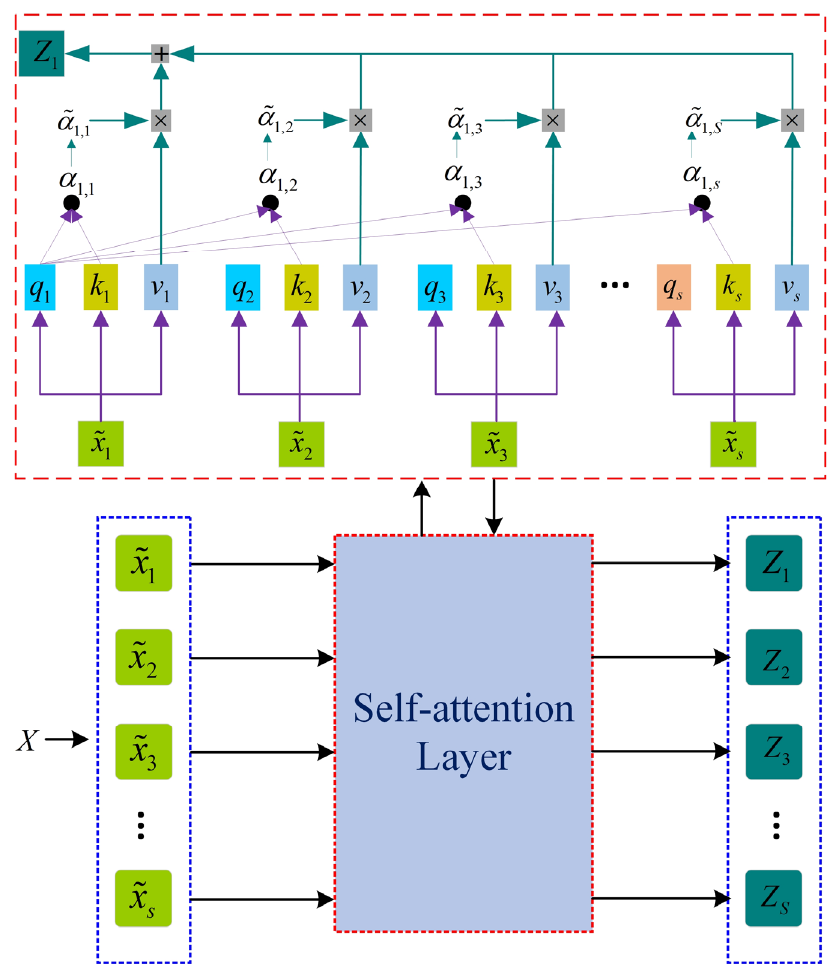
Figure 8. Frame Diagram of the A tt ention Mechanism.